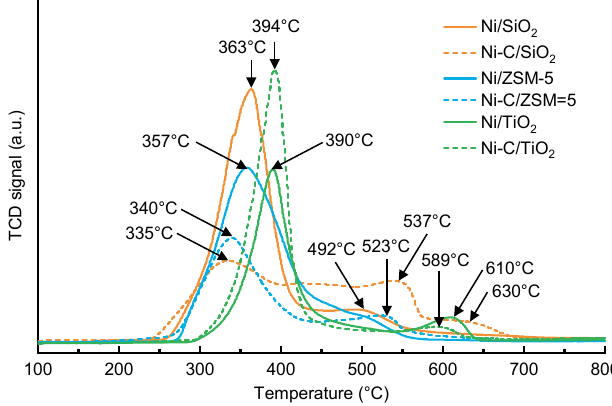
Figure 3. H 2 -TPR profiles of examined catalysts.